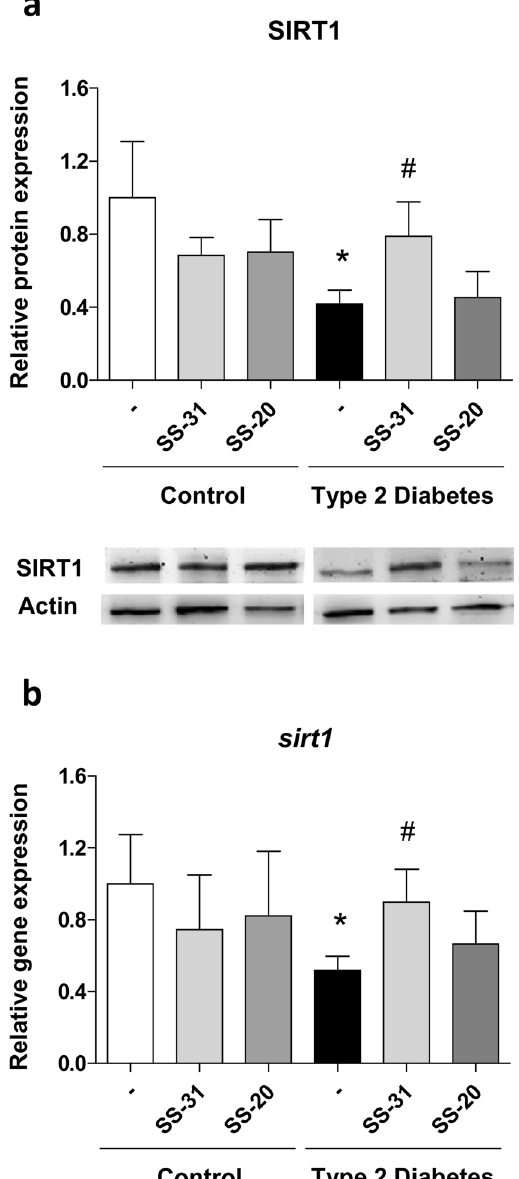
Figure 2. Evaluation of SIRT1 in the absence and presence of SS-31 (30 min, 100 nM) in leukocytes from T2D patients and healthy subjects ( a ) SIRT1 protein levels. ( b ) sirt1 gene expression. * p < 0.05 with regard to control group # p < 0.05 vs . non-treated T2D